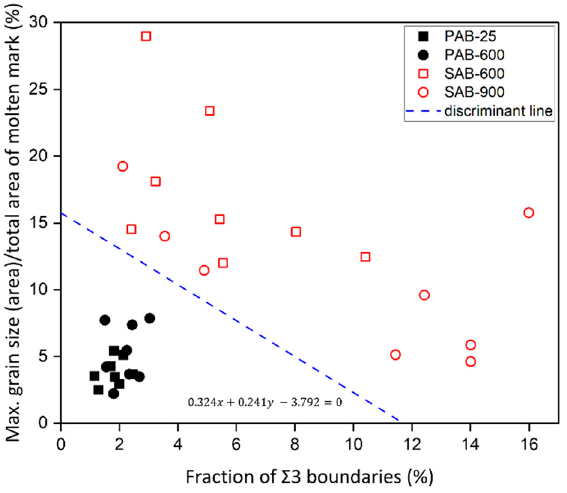
Figure 12. Distribution of primary-arc beads (PABs) and secondary-arc beads (SABs) according to the fraction of Σ 3 boundaries and normalized maximum grain size.